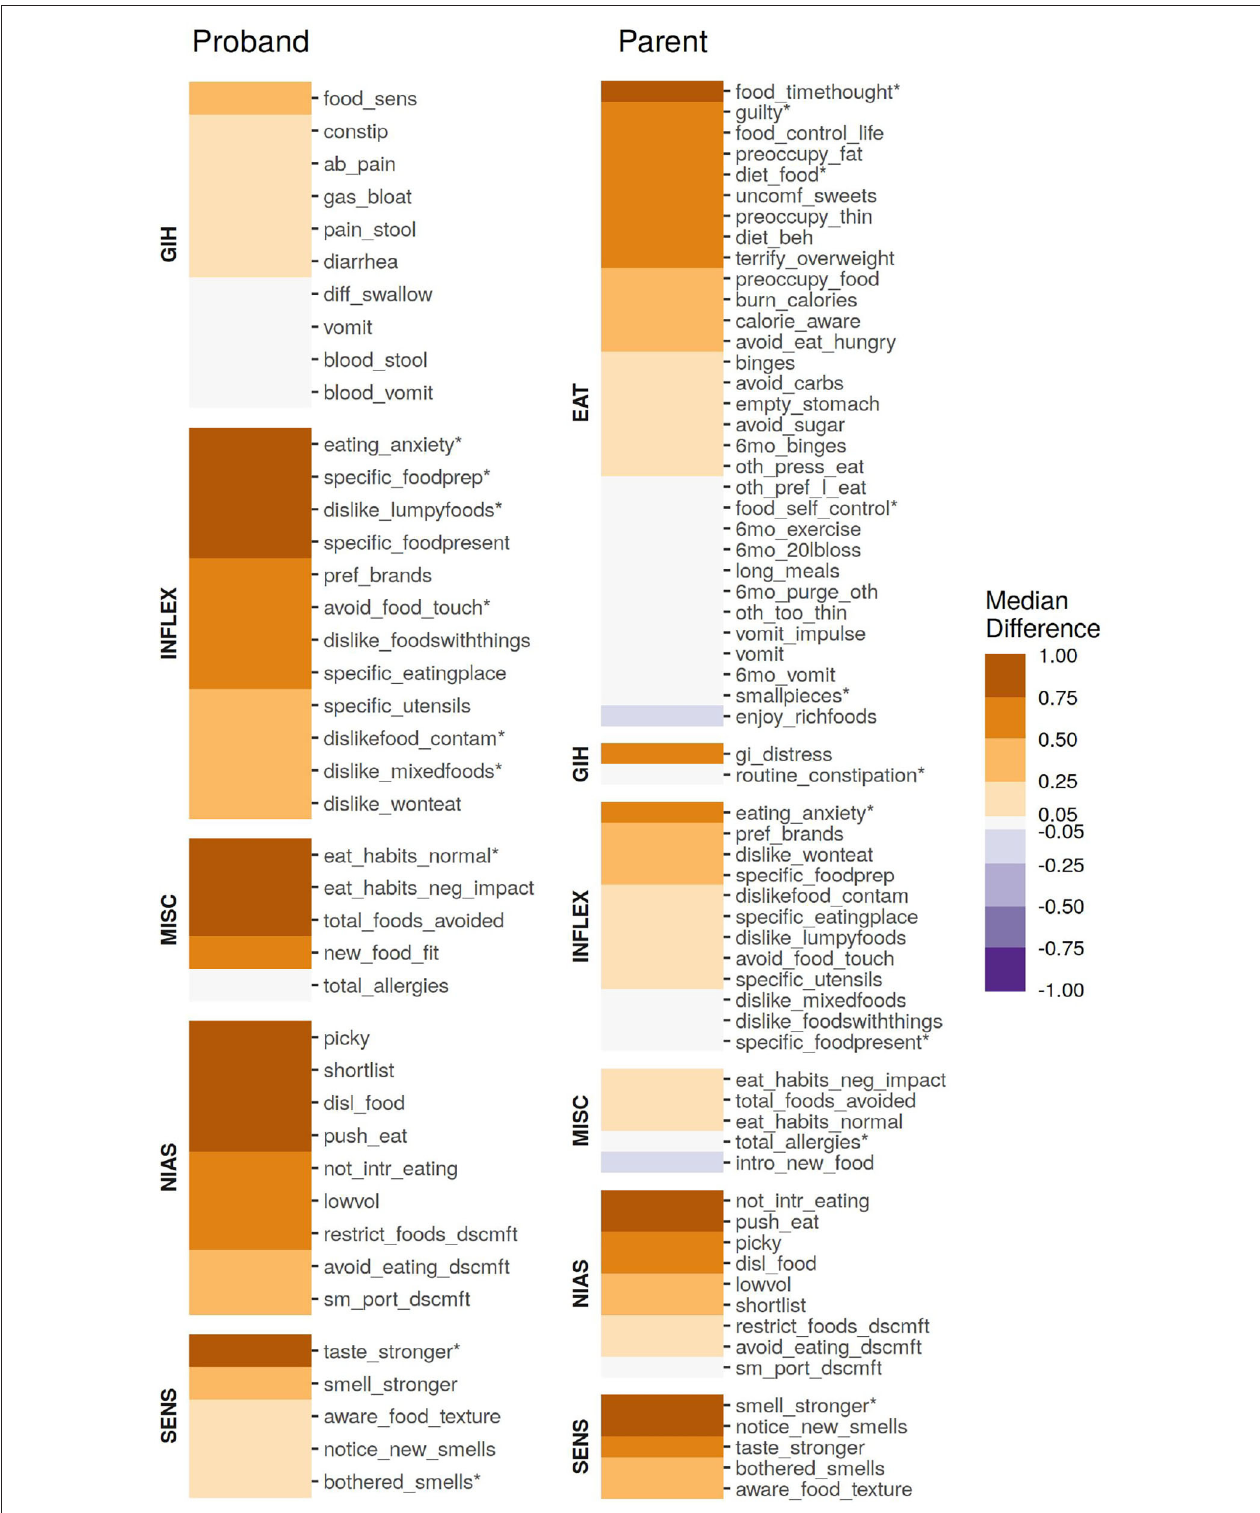
FIGURE 1 | The association of individual age-corrected and scaled items from the parent or proband surveys, quantified as the median difference (location shift) from a Wilcox rank-sum test. All items were scaled to have a unit variance of 1 prior to quantification. Items marked with an asterisk (*) were included in the ARFID Score